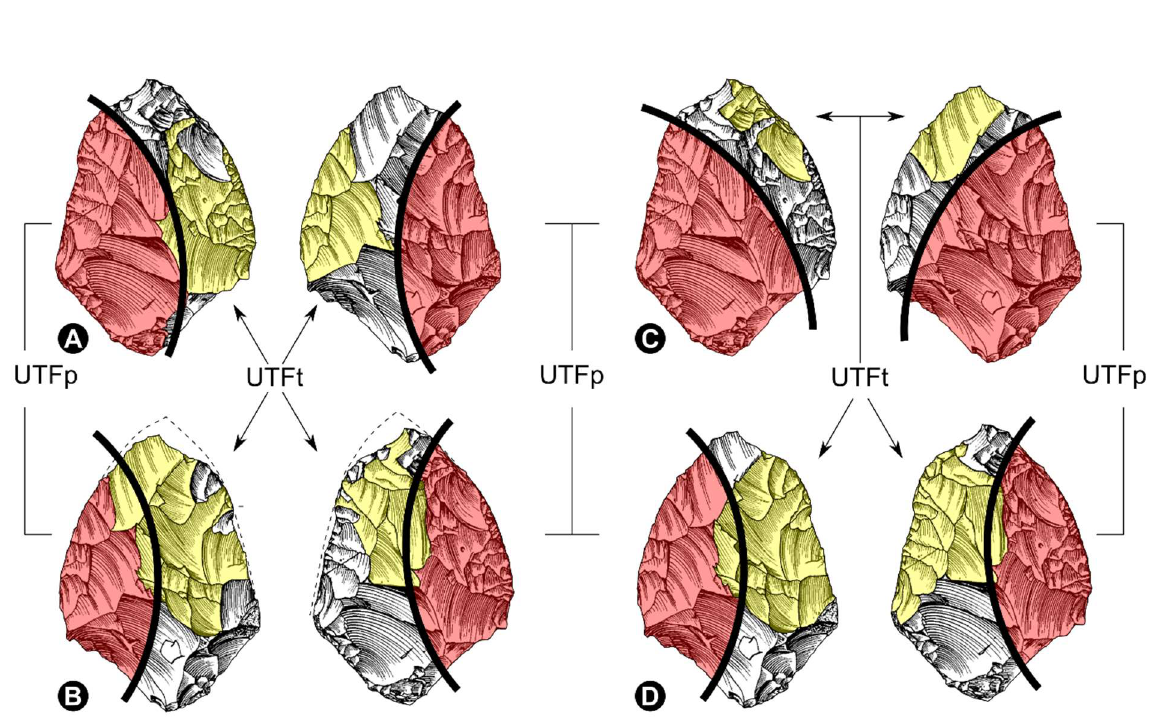
Figure 12. Determination of the technicofunctional units in the structure of the bifacial piece from the C'3 base layer of the Barbas I site, Dordogne. In red, the functional area with a prehensive role (UTFp); in yellow, the functional area with a transformative role (UTFt). The relationship of the two UTFs, assessed at the individual and lithic assemblage level, allowed the identification of four tools (A-D) within the same bifacial piece. As is evident, some areas have a dual function within the same structure (Modified from Boëda 2001: 72, figs